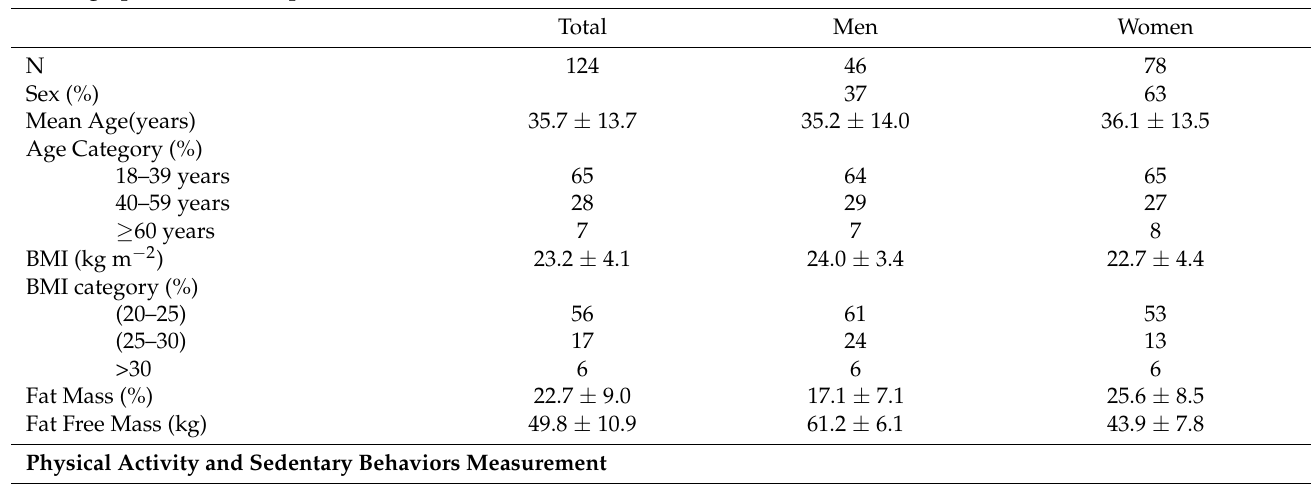
Table 1. Demographic and anthropometric characteristics for all participants, men and women (mean ± sd% in each category of age and body mass index) and data for physical activity and sedentary times ( median ( 1st - 3rd ) quartiles) measured by ONAPS Physical Activity Questionnaire (ONAPS-PAQ), Global Physical Activity Questionnaire (GPAQ), and RM42 accelerometer